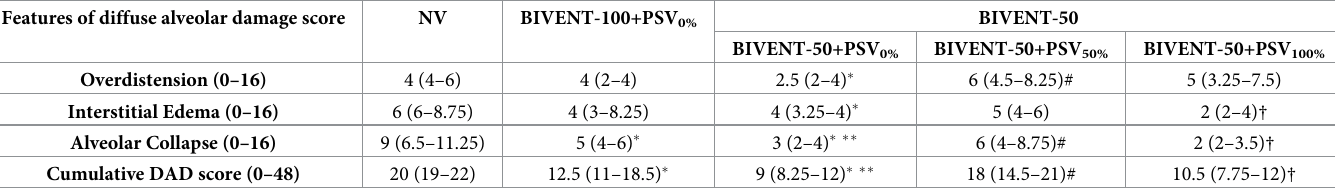
Table 2. Diffuse alveolar damage score.